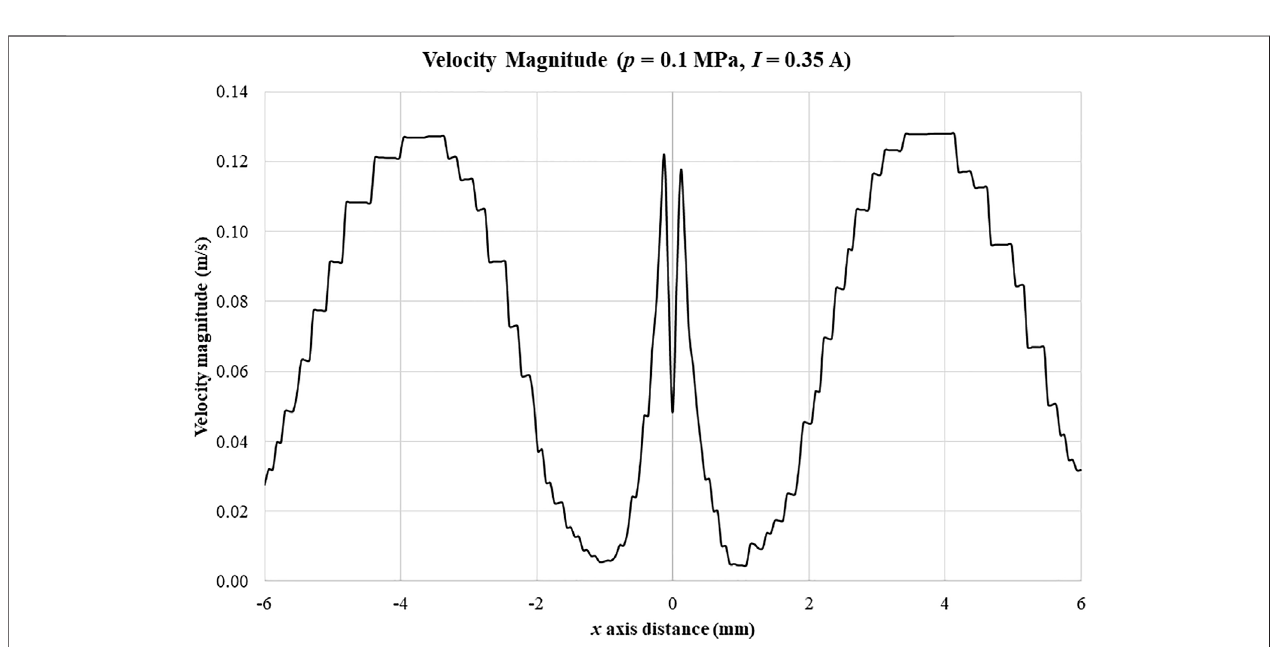
FIGURE 12 | Velocity magnitude in the x axis direction at the center of the inter-electrode gap ( t (cid:2) 50 ms, p (cid:2) 0.1 MPa, I (cid:2) 0.35 A).